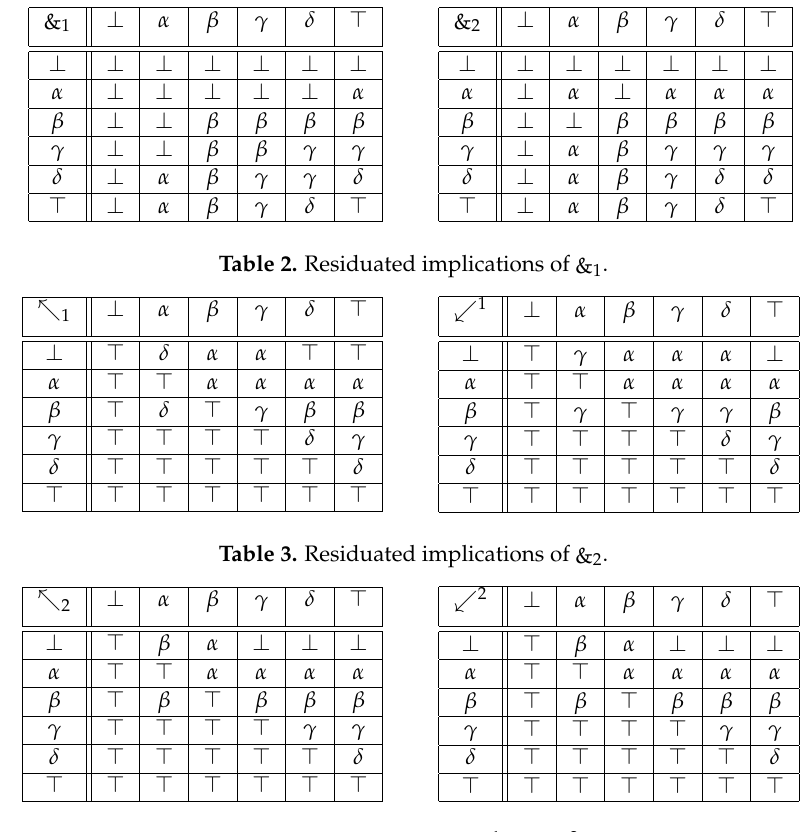
Table 4. Operators ⤣ 1 , 6 1 , ⤣ 2 , 6 2